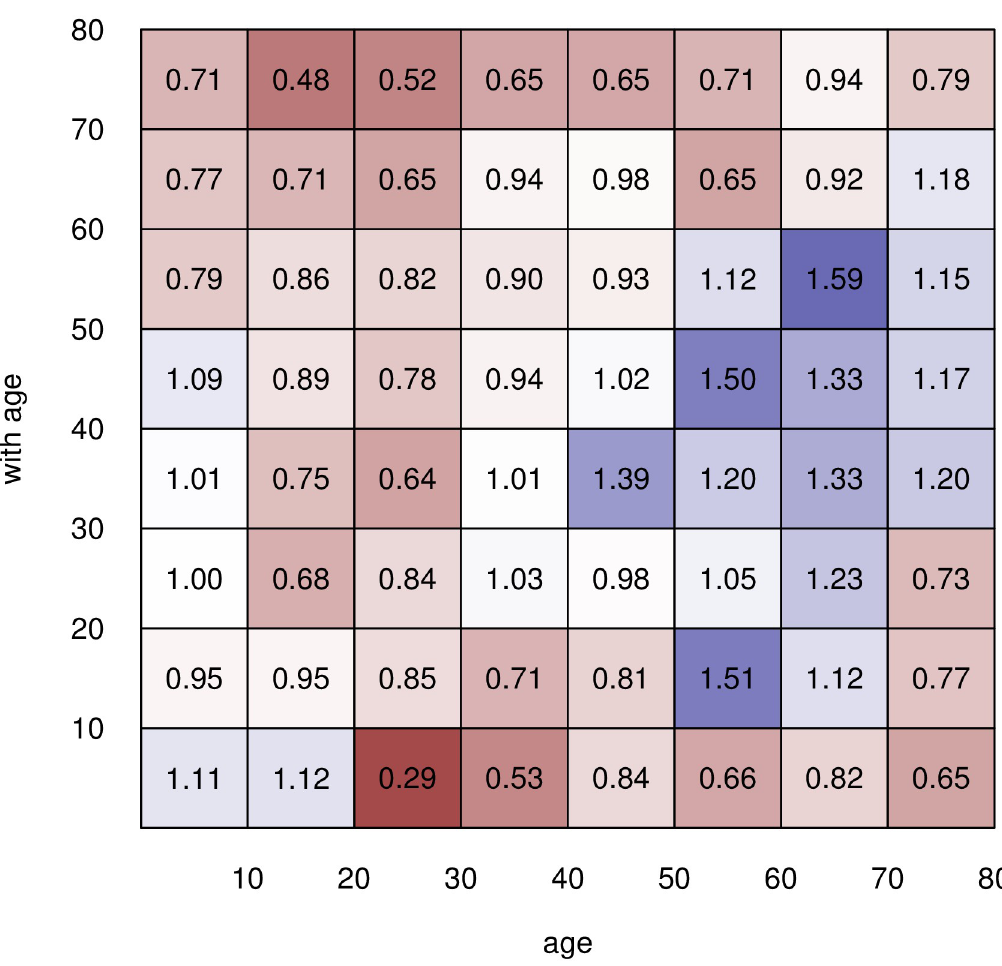
in Germany for different sex and ab